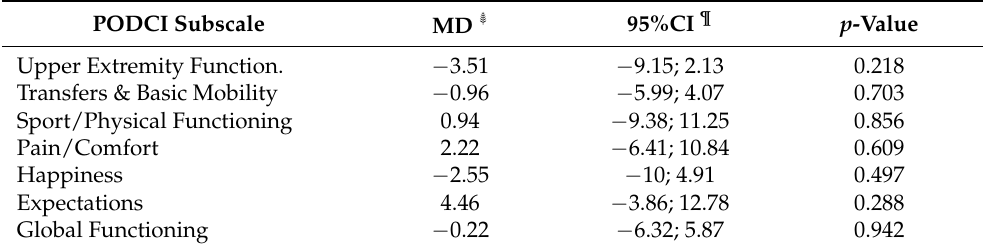
Table 4. Mean difference on psychometric properties of Pediatric Outcome Data Collection Instru- Table 1. Patient demographics and clinical ment (PODCI) between Adolescent self-report and Parent-report forms. Repeated measures linear regression models.